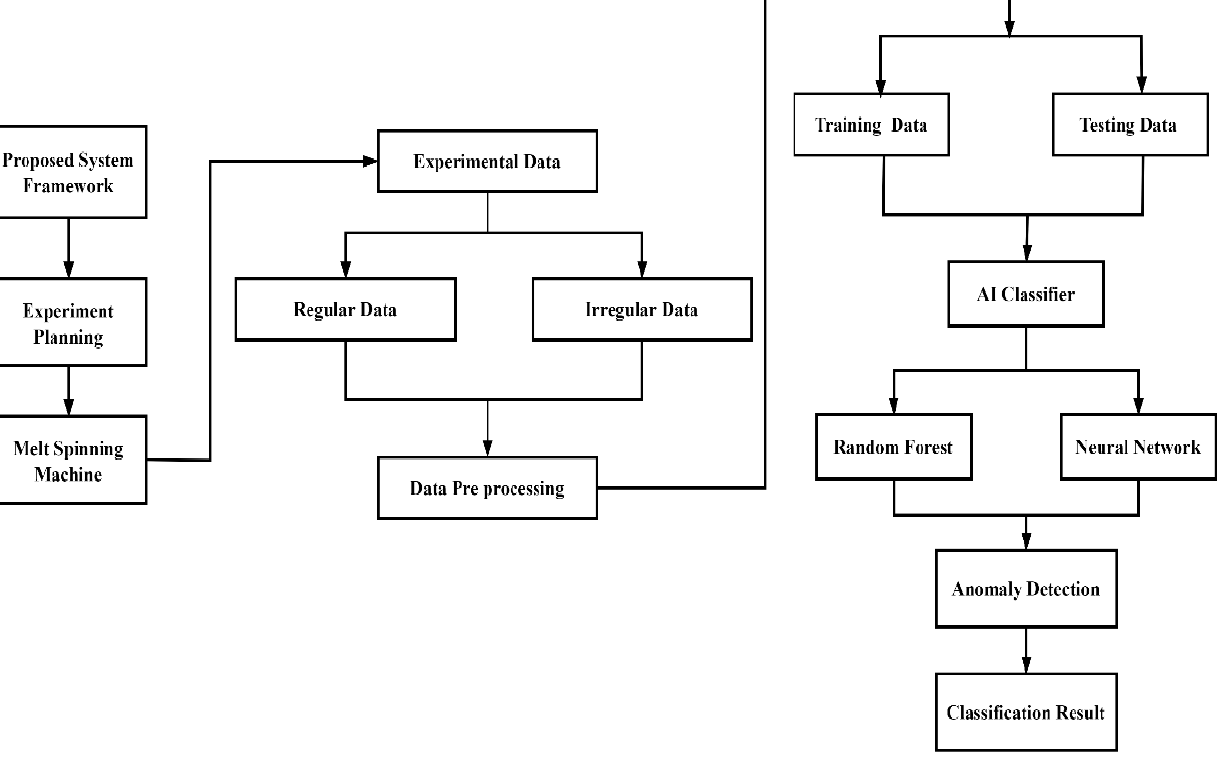
Figure 1. Flowchart for anomaly detection.